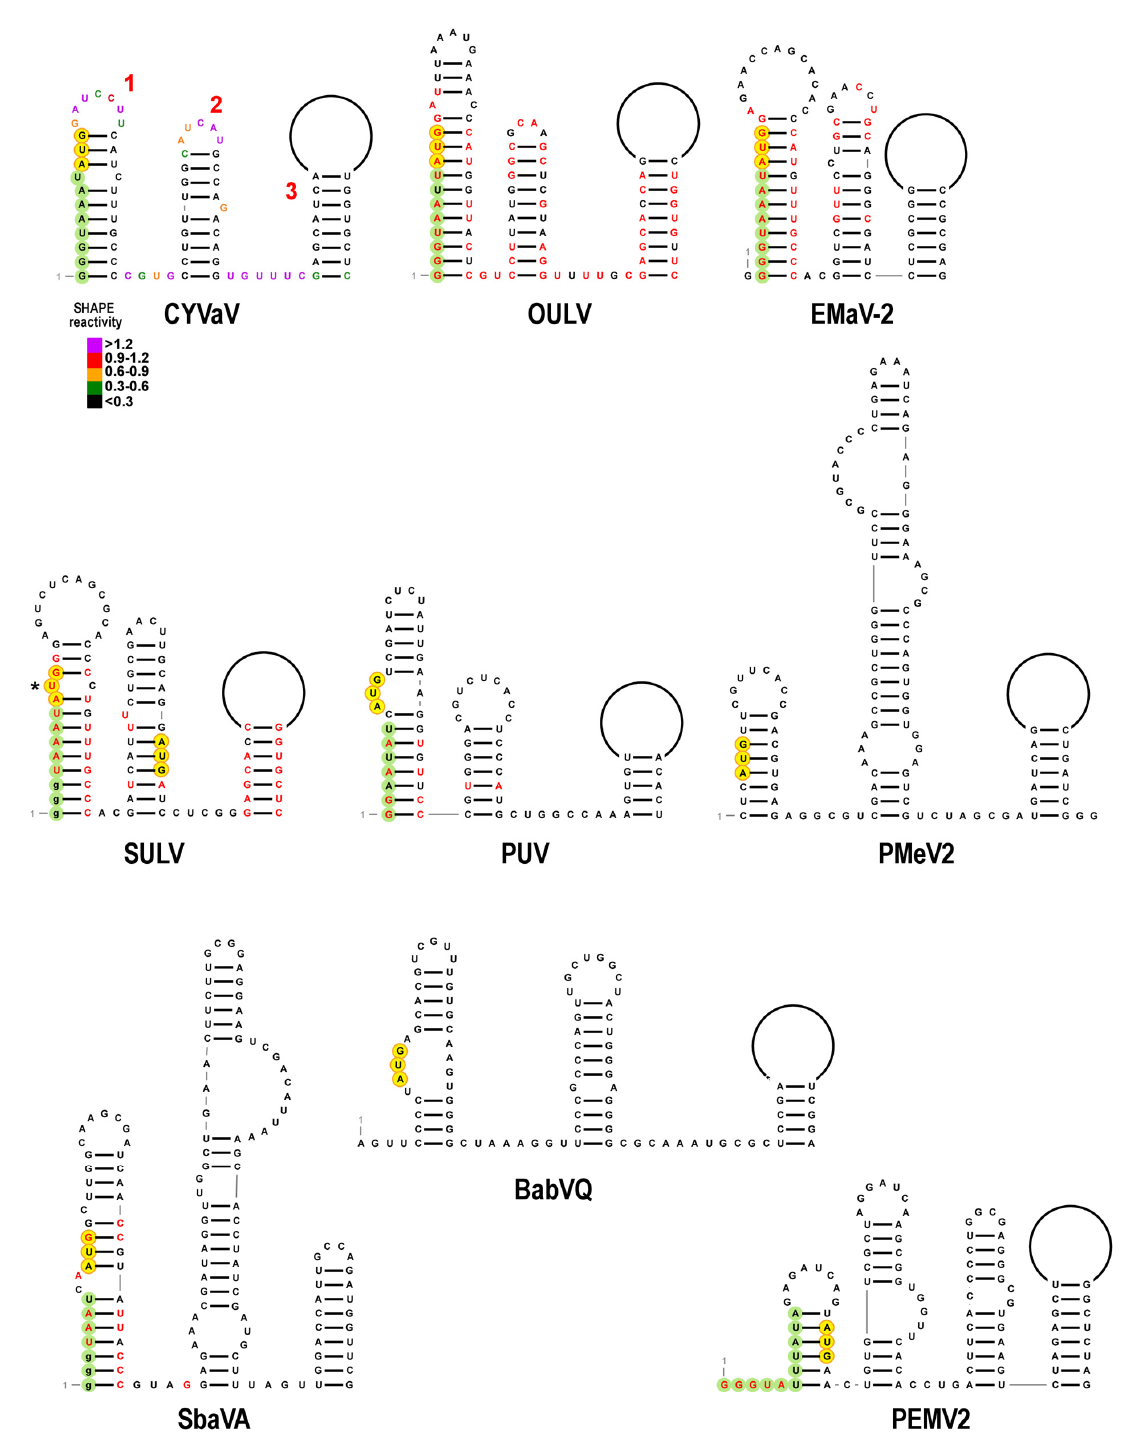
Figure 5. Structures at the 5 (cid:48) end of the ulaRNAs and umbravirus PEMV2. Three hairpin CYVaV structure that was predicted using SHAPE structure probing is shown with proposed structures for the other ulaRNAs. SHAPE data is presented on the CYVaV structure whereas residues in red in the other structures denote sequence conservation with CYVaV. The carmovirus consensus sequence (CCS) is shaded green and initiation codon is shaded yellow. CYVaV stems are numbered according to Figure 3. Asterisk denotes first AUG codon in SULV that is out of frame with most of ORF1. The second AUG is proposed to be the initiation codon for SULV p20. Note that for Class 1 ulaRNAs, PUV, but not PMeV2 or BabVQ, contains a CCS at its 5 (cid:48) end. Guanylates that are absent in reported SbaVA and SULV sequences (but may be present) are in -lower